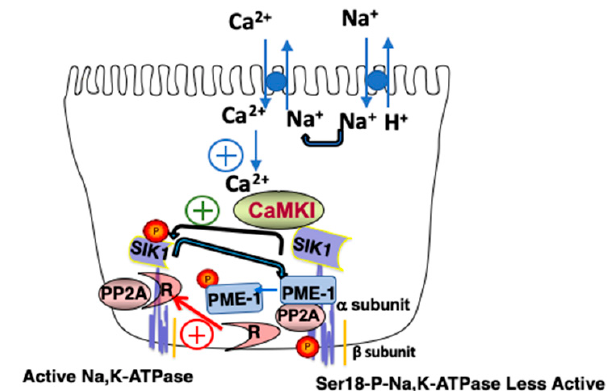
Figure 2. Model of the Basolateral SIK1 Network. An increase in luminal Na + results in an increase in Na + in , the activation of Na + / Ca 2 + exchange, and an increase in Ca 2 + in , which activates CaMK1. Activated CaMK1 phosphorylates SIK1 at Thr322 and activates basolateral SIK1, which as a consequence, phosphorylates PME-1, which dissociates from the Na,K-ATPase complex. PP2A remains demethylated, associates with its regulatory subunit (R), and in this activated state, dephosphorylates Ser18 of the catalytic subunit of Na,K-ATPase (i.e., the α subunit), activating the transporter. If the indicated reaction has a positive e ff ect upon activity, it is indicated by a plus contained within a circle.